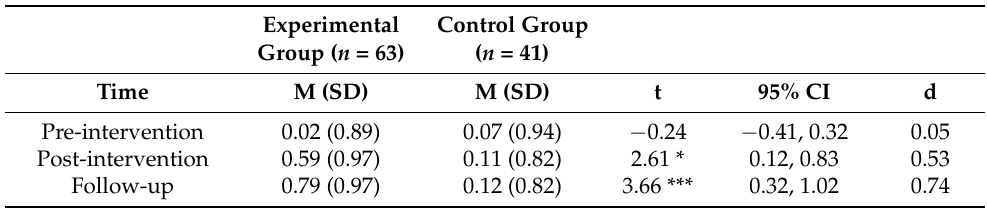
Table 1. Comparison of mean TEC scores between the experimental and control groups at the three measurement times.